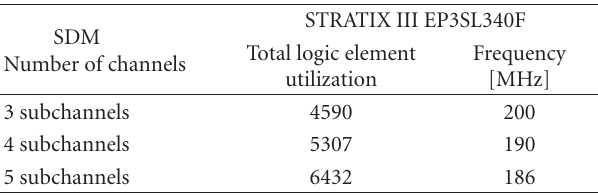
Table 2: Synthesis results SDM router (18 bits per subchannel).